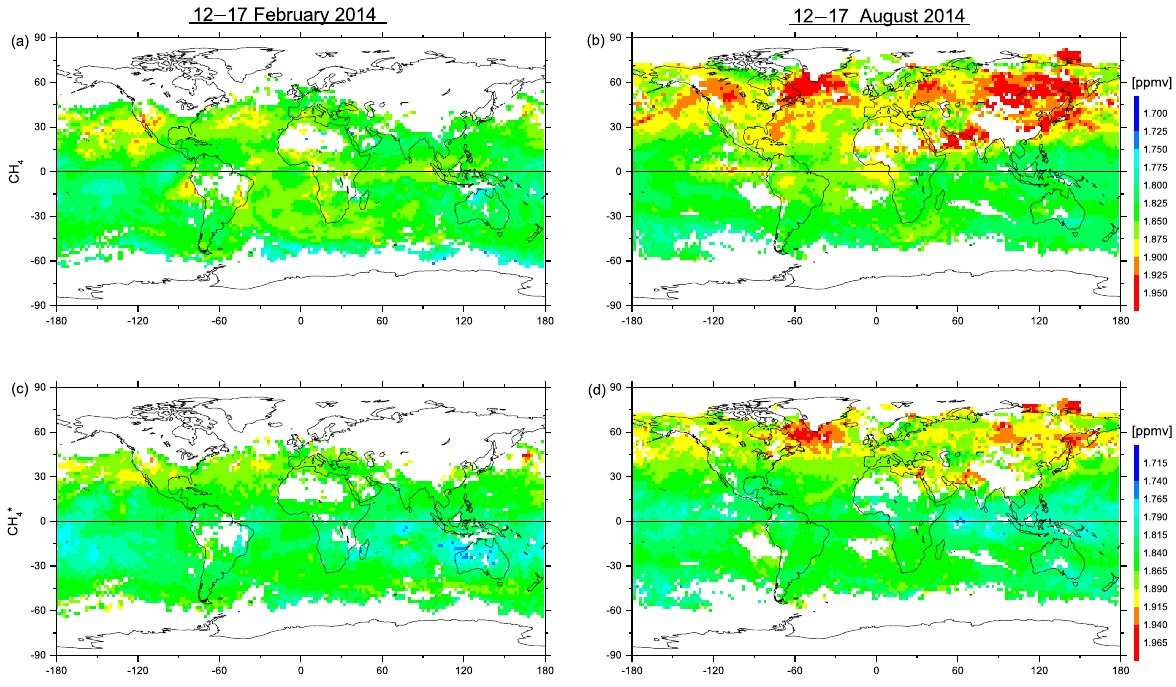
Figure B2. Same as Fig. B1, but for the 10.9km retrieval